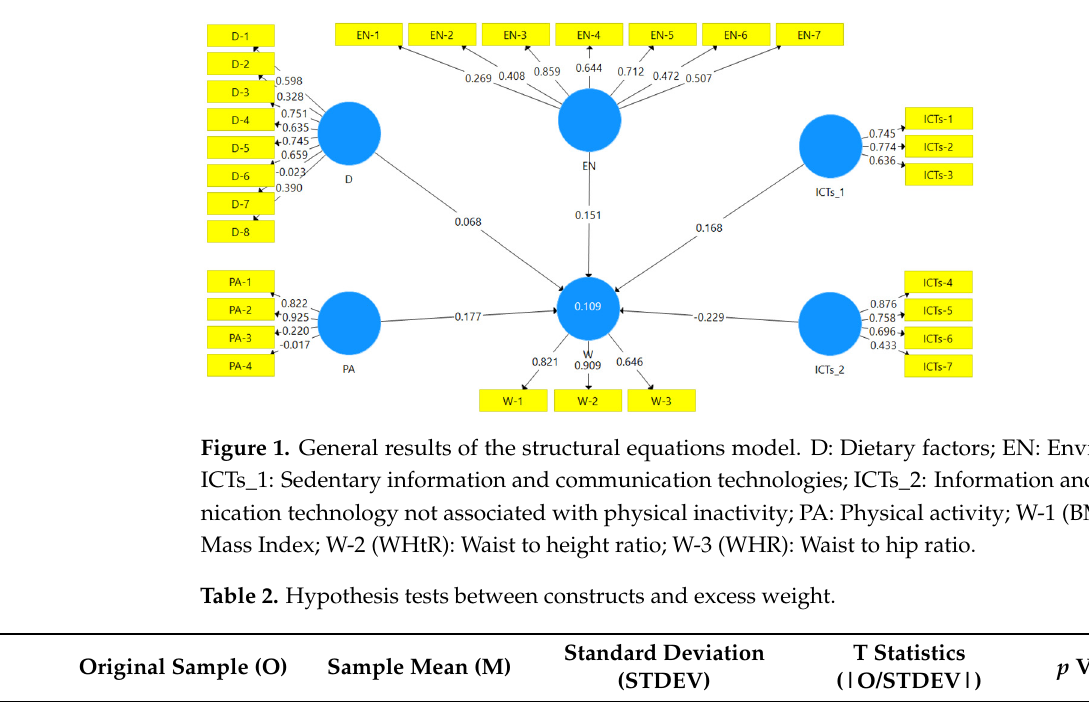
Table 2. Hypothesis tests between constructs and excess weight.